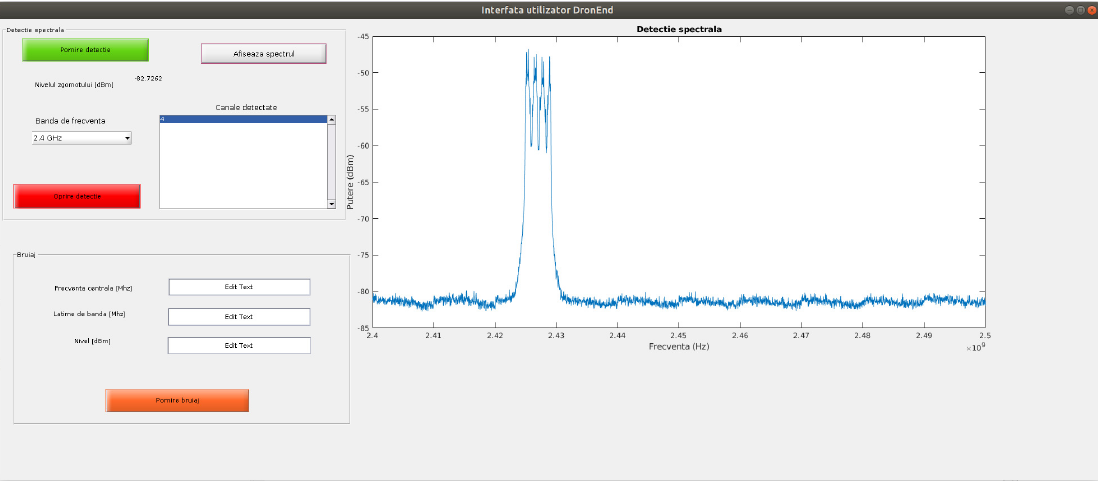
Figure 3. Graphical user interface of the spectrum sensing process implemented in the DronEnd system, showing the signal transmitted by the DJI Mavic Air drone in the 4th channel of the 2.4 GHz ISM